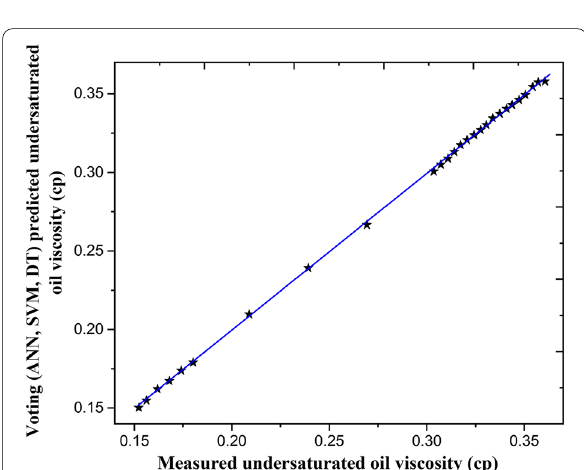
Fig. 25 Cross plot of voting (SVM, LR, DT) predicted values versus measured values